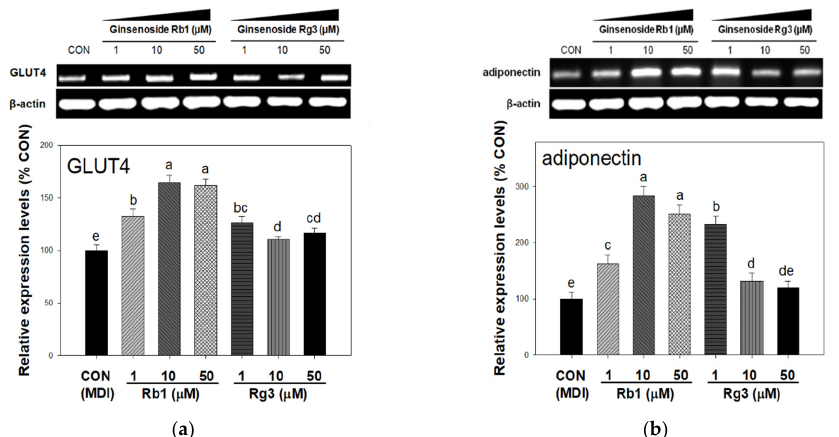
Figure 3. Changes of GLUT4 and adiponectin mRNAs expression by ginsenosides Rb1 and Rg3 during the differentiation of 3T3-L1 preadipocytes. Values are the means ± SD of four samples. a–e Bars with different letters indicate statistically significant differences among groups at p < 0.05.